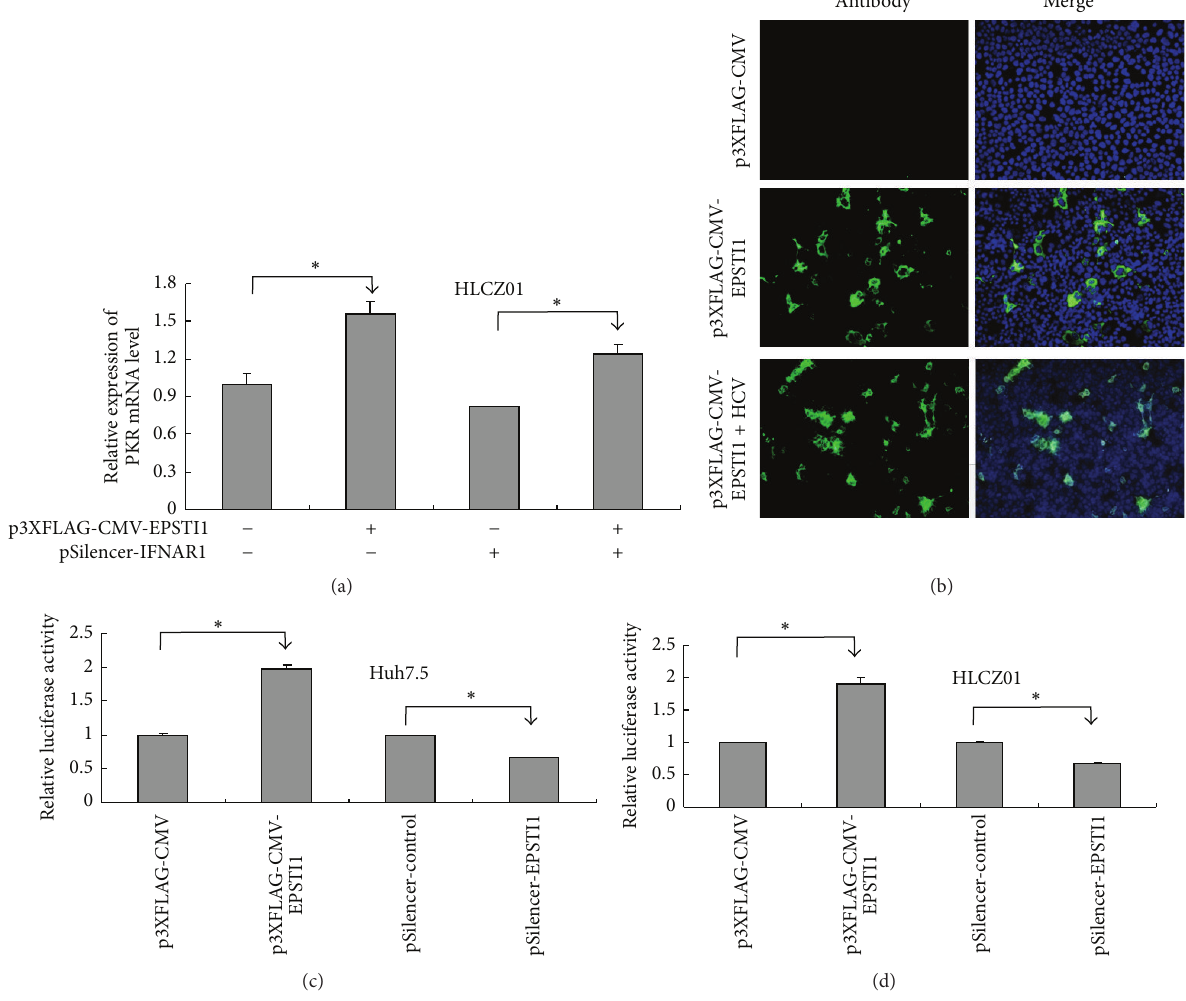
Figure 7: EPSTI1 upregulates PKR expression by activating PKR promoter. (a) HLCZ01 cells were transfected with p3XFLAG-CMV-EPSTI1 or/and pSilencer-IFNAR1 followed by HCV infection (MOI = 0.1). PKR mRNA was detected by real-time PCR and normalized with